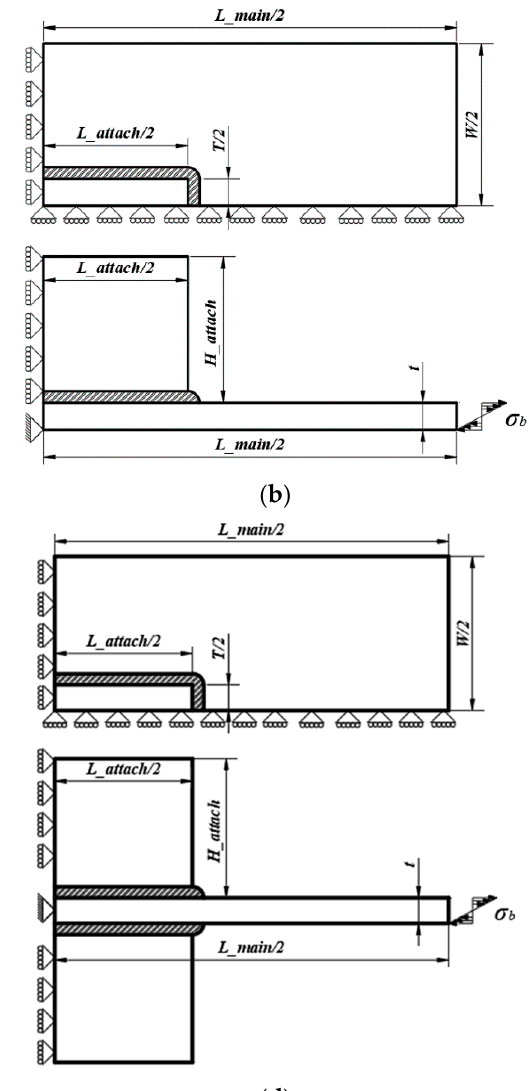
4 of 23 Figure 1. The spline model: ( a ) double-attachment gusset; ( b ) bead shape; ( c ) spline model for single attachment; ( d ) spline model for double attachments. 2.2. The Finite Element Model for Welded Joints A one-quarter 3D model with symmetric boundary conditions was employed to cal- culate the SCF of gussets with single attachment and double attachments under tensile and bending stress. The unitary tensile stress was applied to the extremity of the main plate acting as the nominal stress ( σ nom ) for the tensile stress ( σ t ), while the linearly distrib- uted unitary stress was applied for the bending stress ( σ b ). The boundary and loading